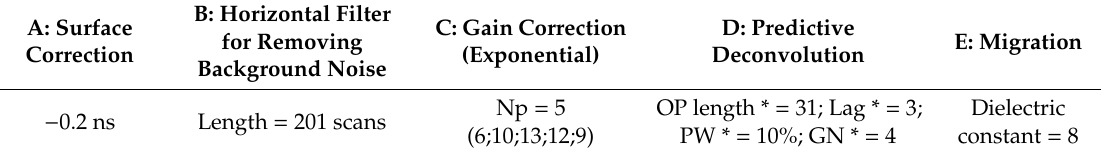
Table 2. Processing flowchart and settings